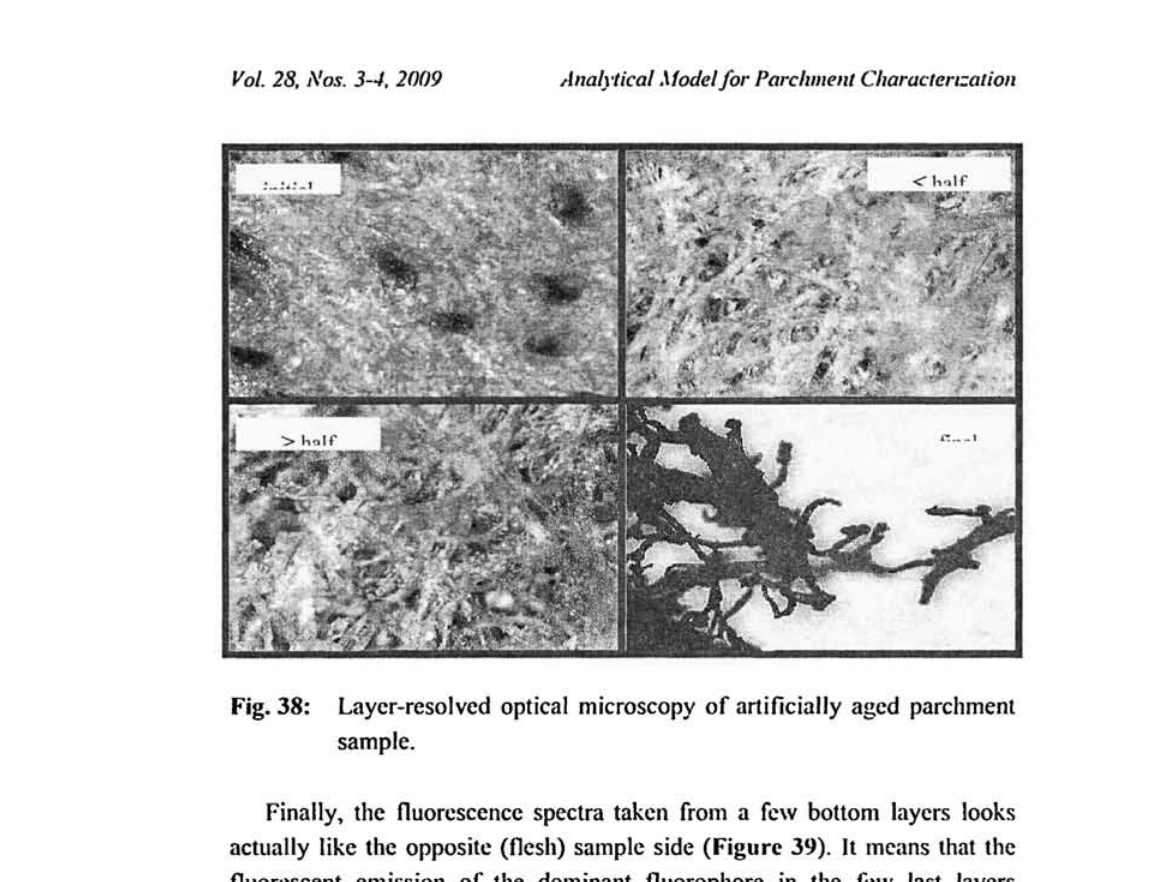
Fig. 38: Layer-resolved optical microscopy of artificially aged parchment